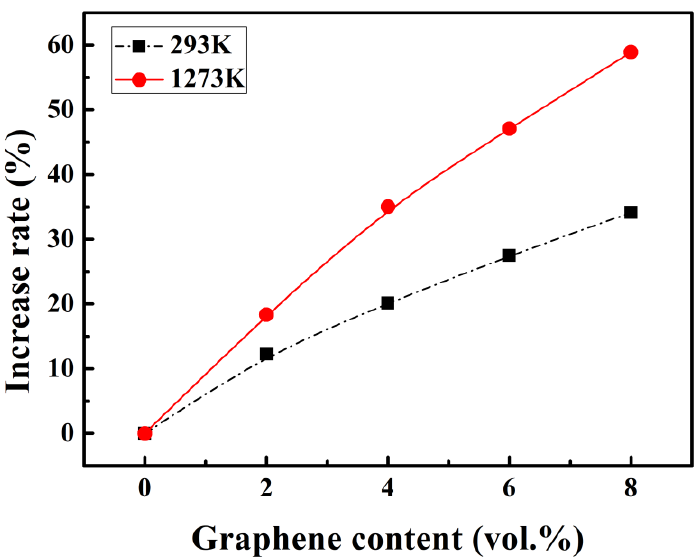
Figure 7. Influence of graphene content on thermal conductivity increase rate of pellets .